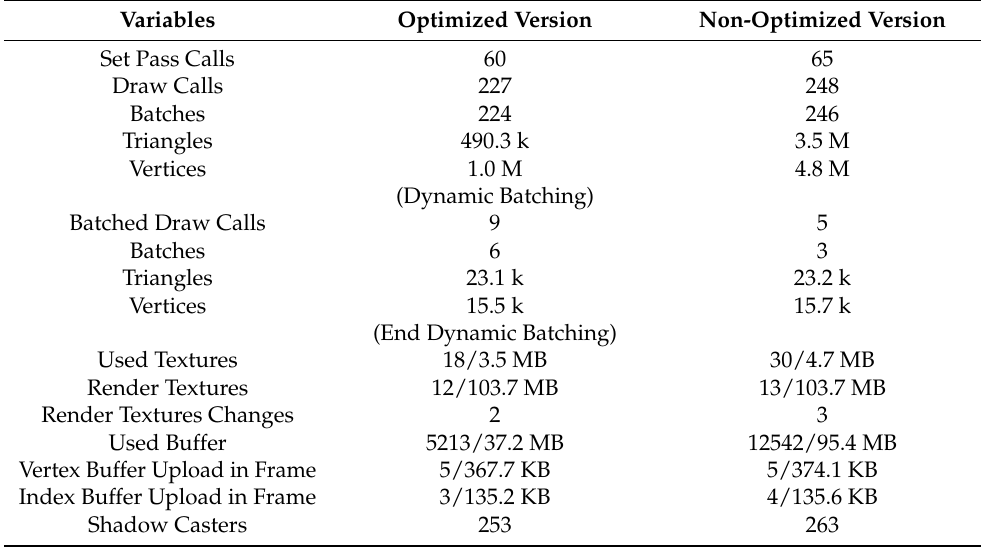
Table 4. Rendering data from a gameplay snapshot with the lowest FPS in the CPU usage diagram.